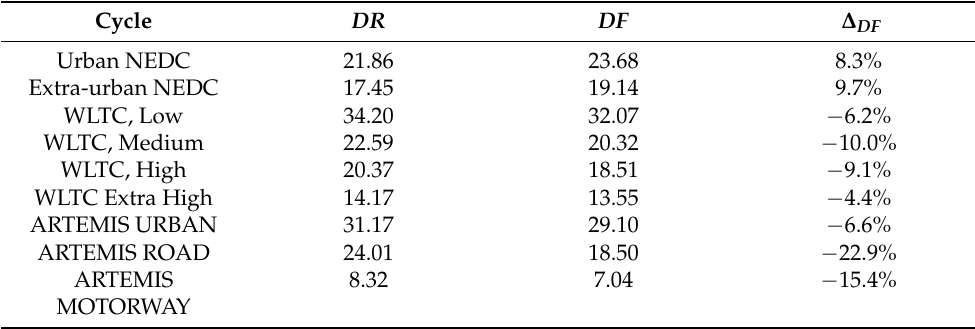
Table 5. Dilution ratio ( DR ) and dilution factor ( DF ) in each phase of NEDC, WLTC and ARTEMIS driving cycles for vehicle with SI engine, Euro 6 WLTP.